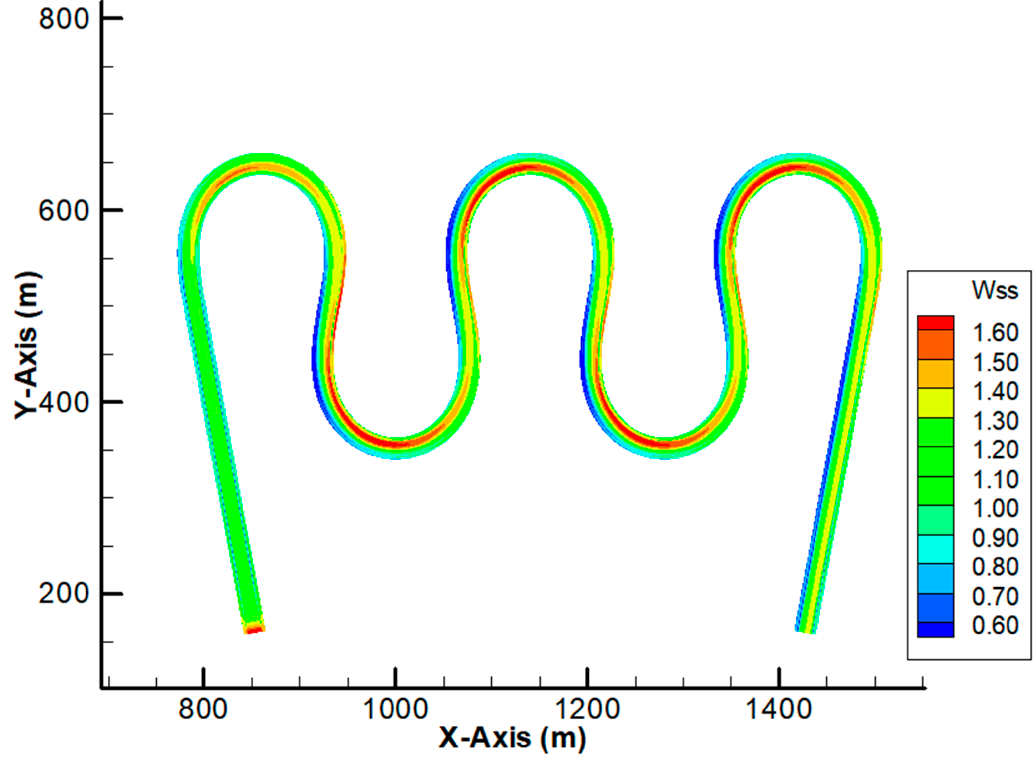
Figure 30. Channel bottom shear stress contours for Simulation Set 5 with a sinuosity of 2.75.